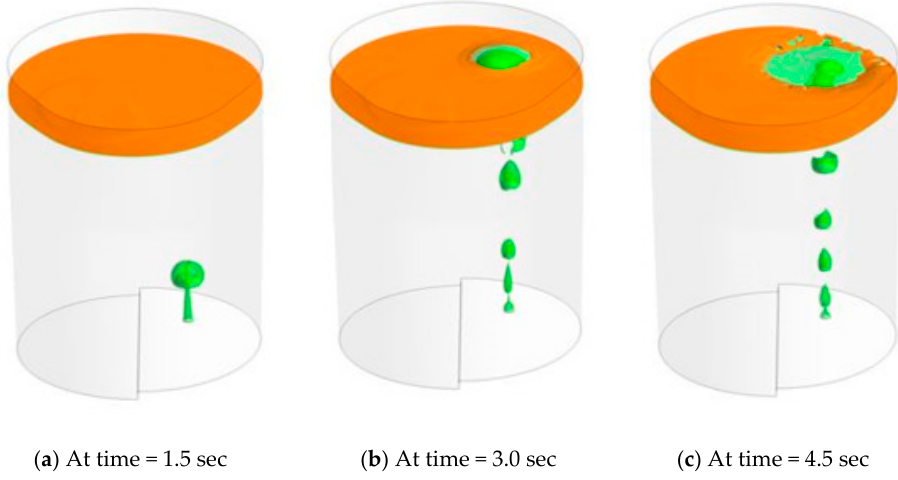
Figure 2. The argon gas floating and open-eye formation process: Q = 200 NL/min.